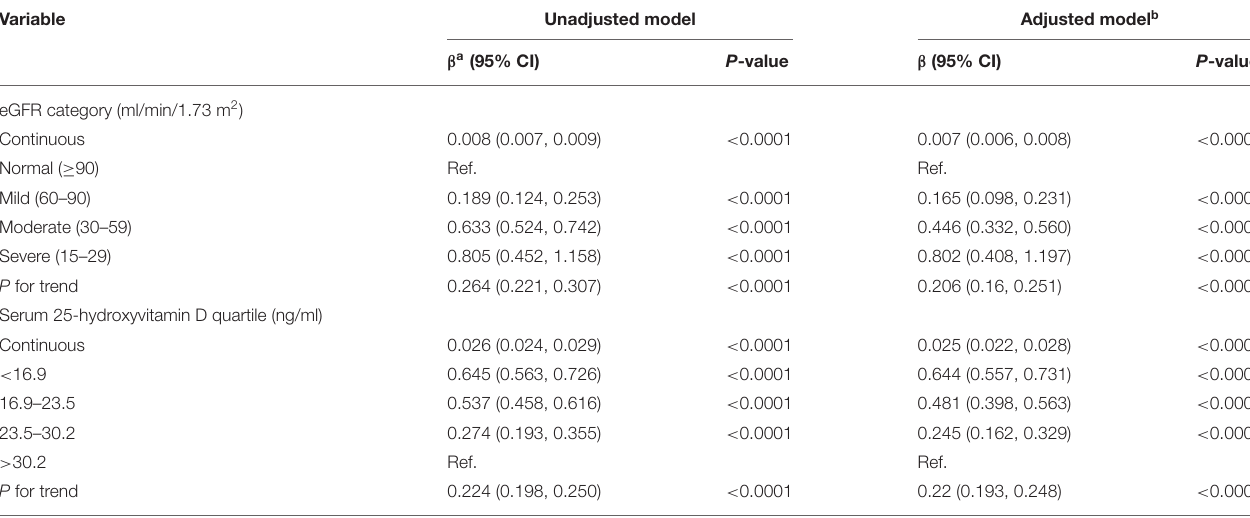
TABLE 5 | Association between kidney function and IR and association between 25-hydroxyvitamin D concentrations and IR.